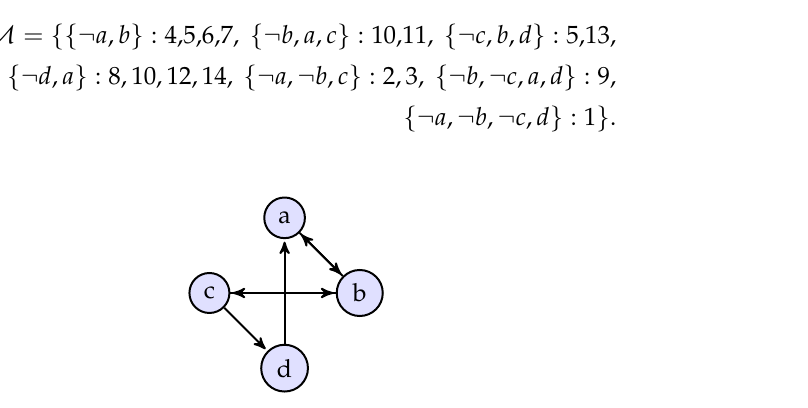
Figure 5. A strongly connected communication graph with 4 vertices, 3 simple cycles, 1 non-simple